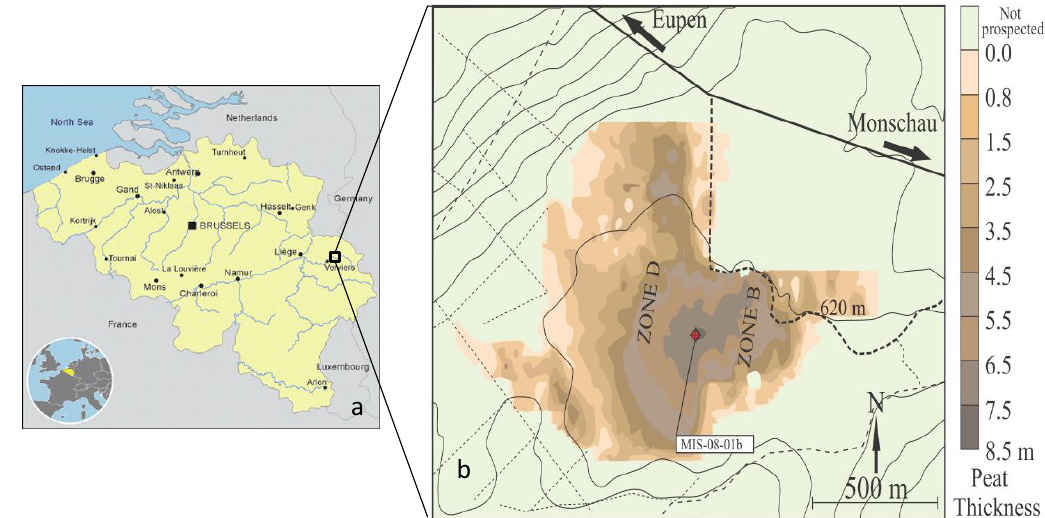
Fig. 1. (a) Location of the Misten peat bog in eastern Belgium, and (b) map of the Misten peat bog modified from De Vleeschouwer et al. (2007). The colouring indicates the peat thickness as deduced from surface radar prospection (Wastiaux and Schumacher, 2003). The red dot shows the location of the MIS-08-01b